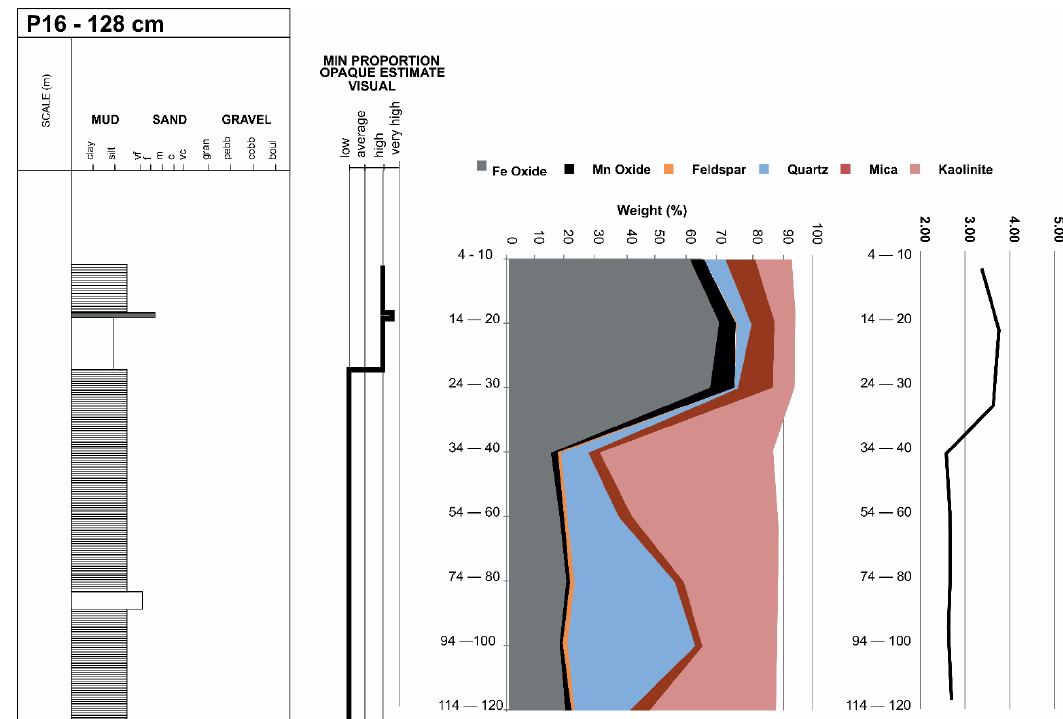
Figure 8. Multiproxy display of results obtained from P16 samples. From left to right one can observe the log with textural description, opaque relative proportions, modal mineralogy and density. Sampled intervals are indicated by the horizontal axis on the last two charts.